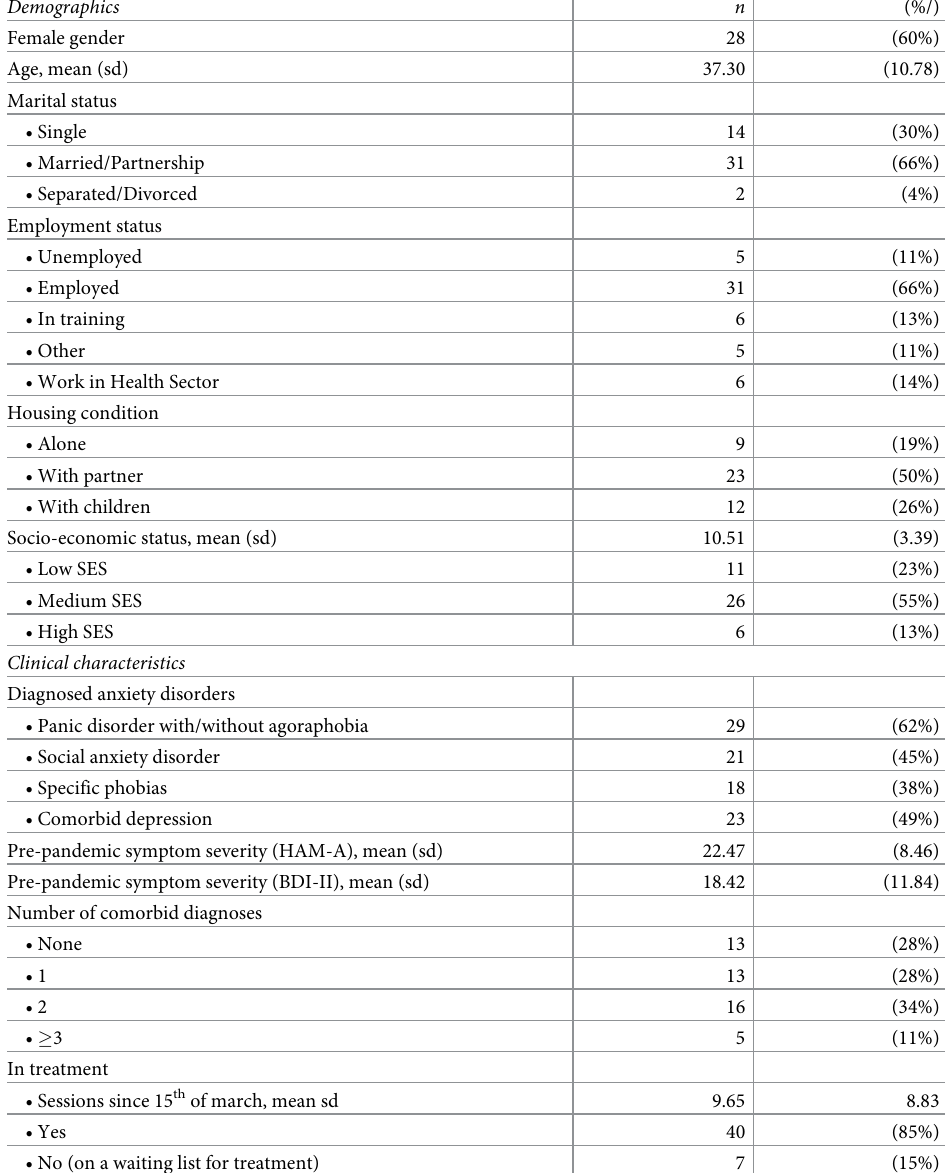
Table 1. Demographic and clinical characteristics of participants (N = 47).